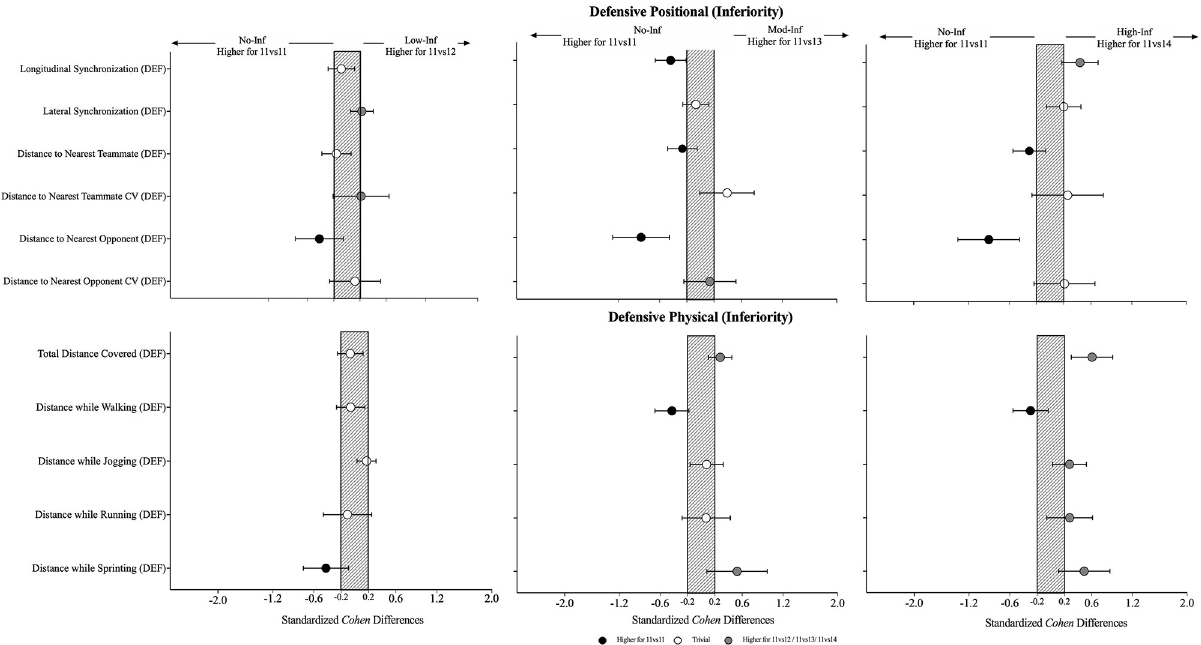
Fig 5. Standardised (Cohen) differences in physical and collective tactical variables considering the increase in the number of opponents (opposition-perspective) during the defensive phase. Error bars indicate uncertainty in the true mean changes with 90% confidence intervals. Dist = distance;